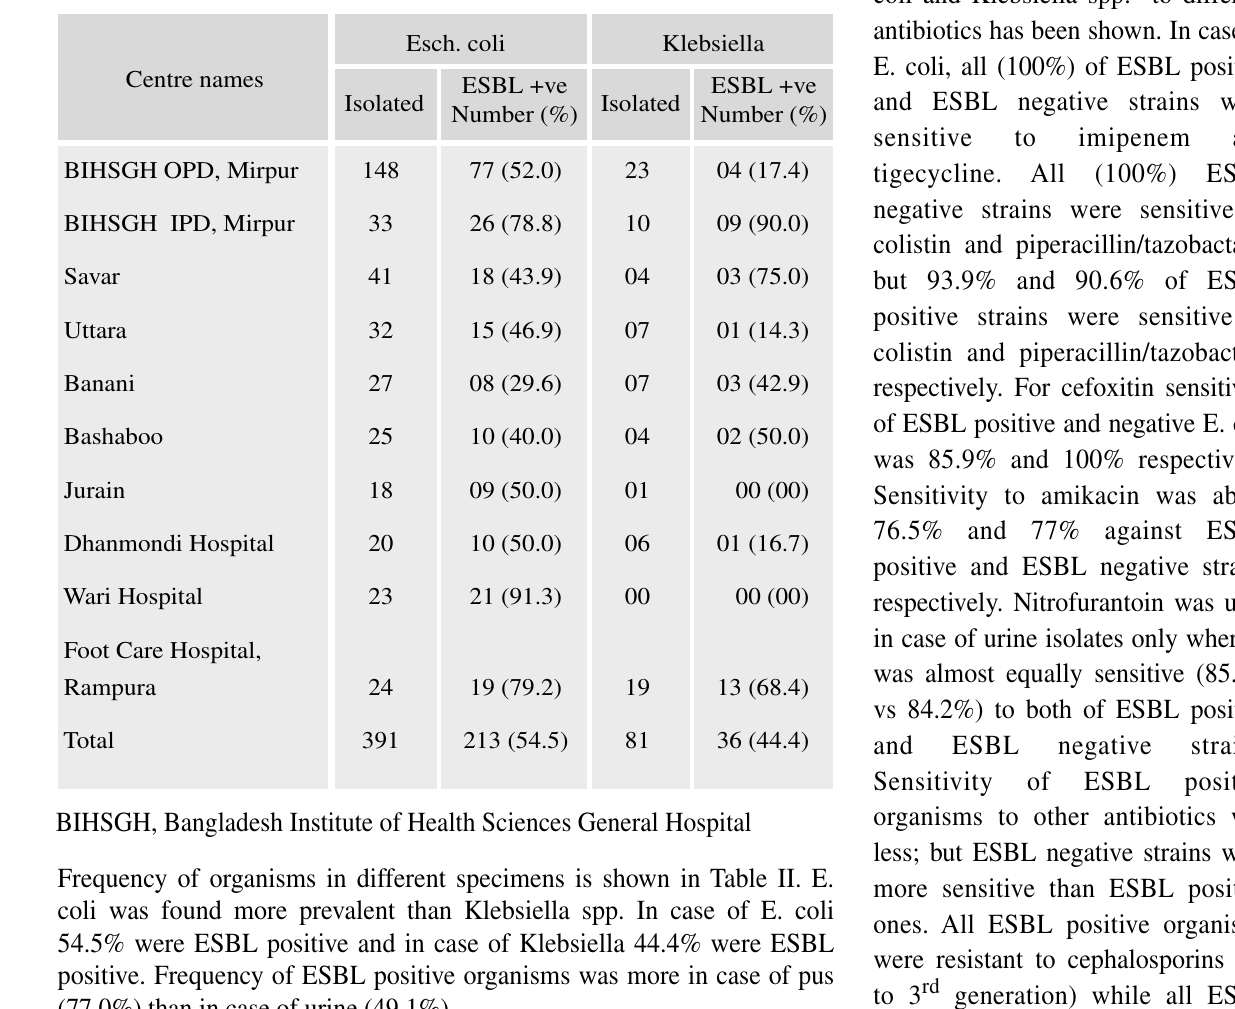
Table I: Distribution of ESBL positive organisms in different sites (cid:13) of Dhaka